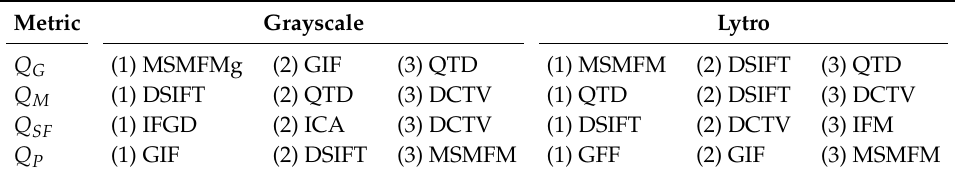
Table 4. Summary of performance evaluation using feature based metrics. For each metric, the numbers (1), (2), and (3) show the three best performing algorithms, respectively.